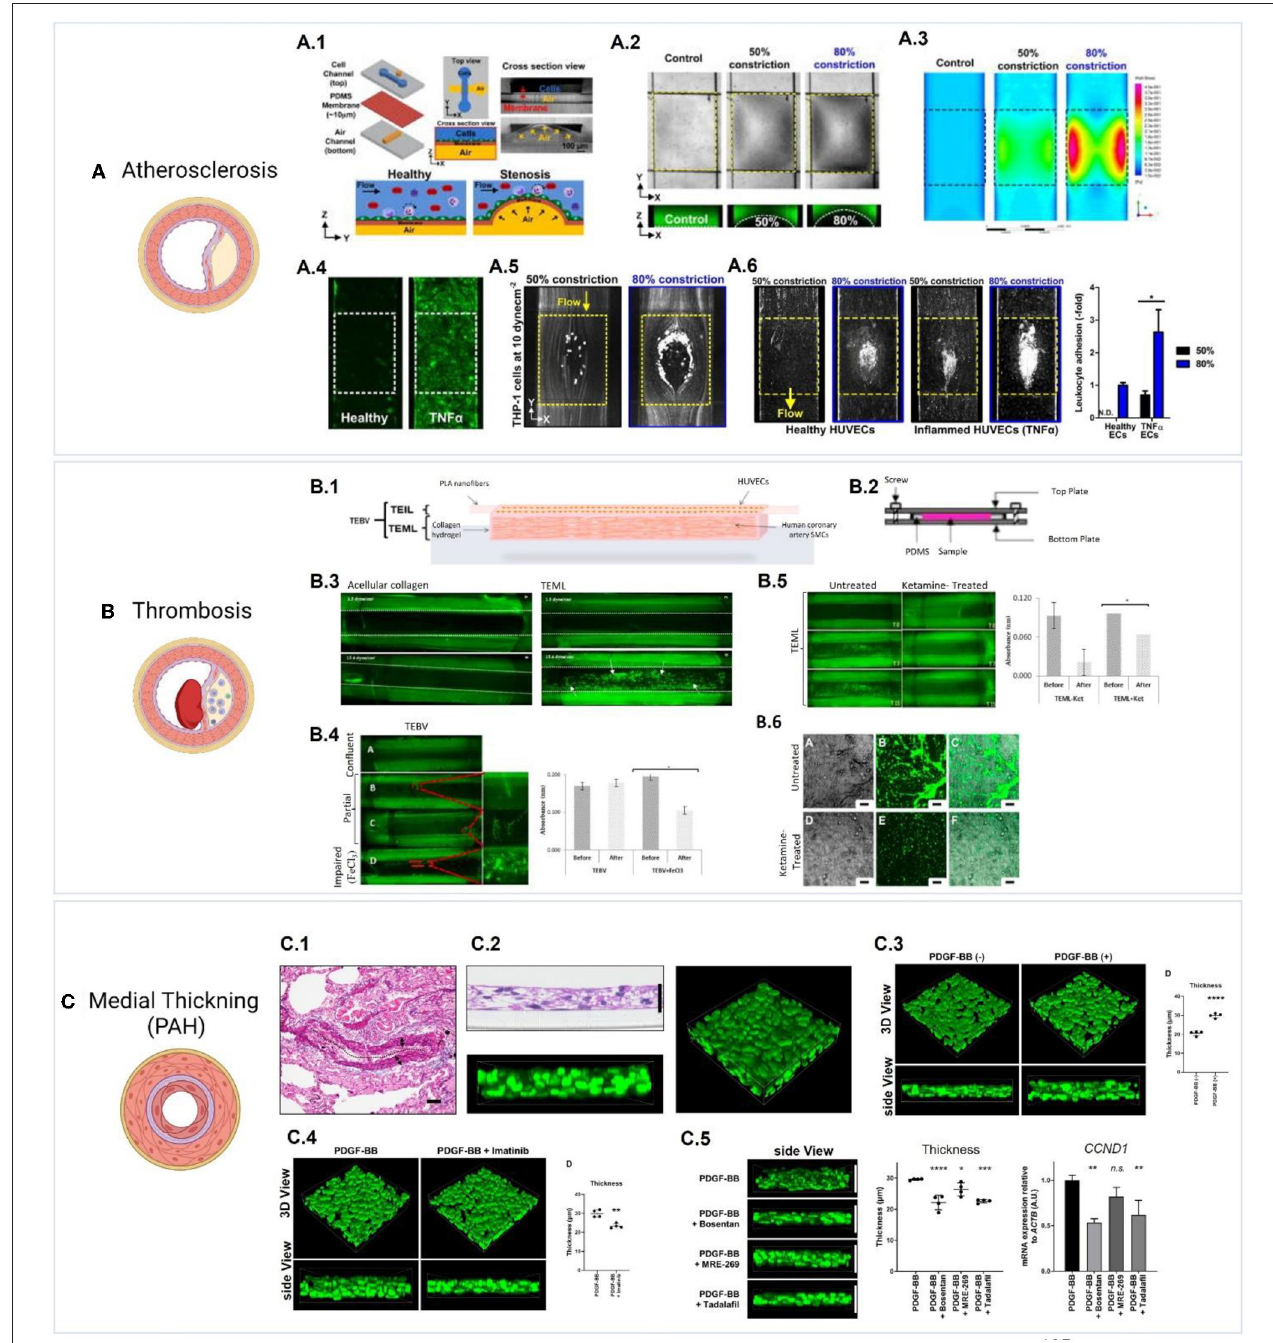
FIGURE 5 | Examples of 3D vascular disease models. (A) Model of atherosclerosis (193). (A.1) The design of a pneumatic-controlled 3D stenosis blood vessel model composed of a cell culture channel and an air channel separated by a thin PDMS membrane (193). Pumping air into the air channel deflects the PDMS membrane upwards leading to constriction, which mimics stenotic plaque formation and vascular constriction in atherosclerosis. (A.2) Shows the channel constriction and the stenotic region (Yellow box) using bright-field images, and fluorescent images of channels loaded with FITC dye. (A.3) Fluid simulations representing wall shear stress show distinct high shear and low shear areas at 50 and 80% constriction. To study leukocyte-endothelial interactions using this model, monocytes (THP-1) were perfused over HUVECs with inflammation induced by prior treatment with TNF- α , and adhesion patterns were assessed under varying constriction degrees and shear stress conditions. (A.4) Shows the expression of ICAM1 (green) in healthy and TNF- α treated HUVECs. (A.5) shows the adherence of THP-1 to 50 and 80% constricted area at 10 dyn/cm 2 to TNF- α treated HUVECs. (A.6) Perfusion of whole blood into the stenosis chip at 1 dyn/cm 2 resulted in leukocyte adhesion to both healthy and TNF- α treated HUVECs following 4h of perfusion, with inflamed HUVECs showing a significantly higher adhesion at 80% constriction. Figures were